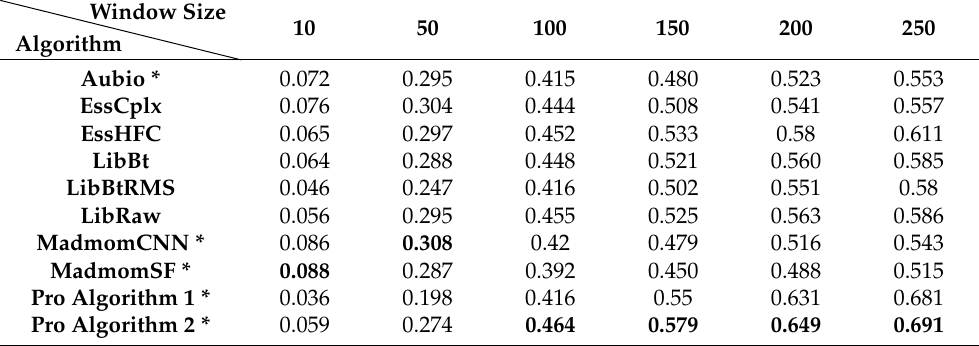
Table 1. The average of the F-measures of all the algorithms on the Erkomaishvili dataset based on six window sizes, from 10 to 250 ms.